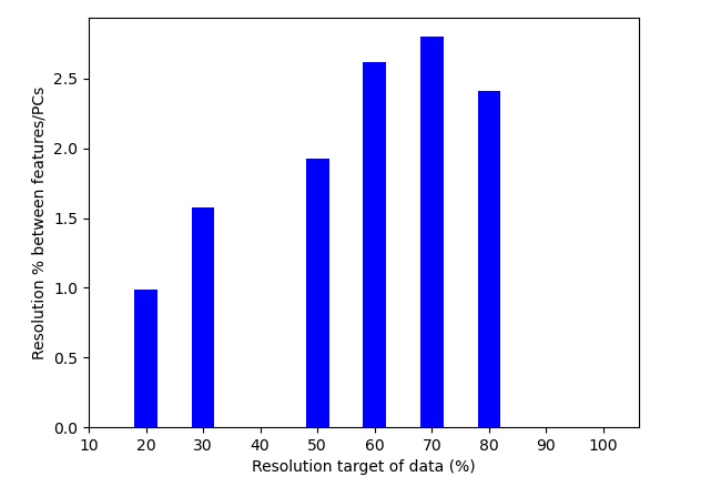
Figure 14. Differences of resolution in percentage between feature extraction and feature